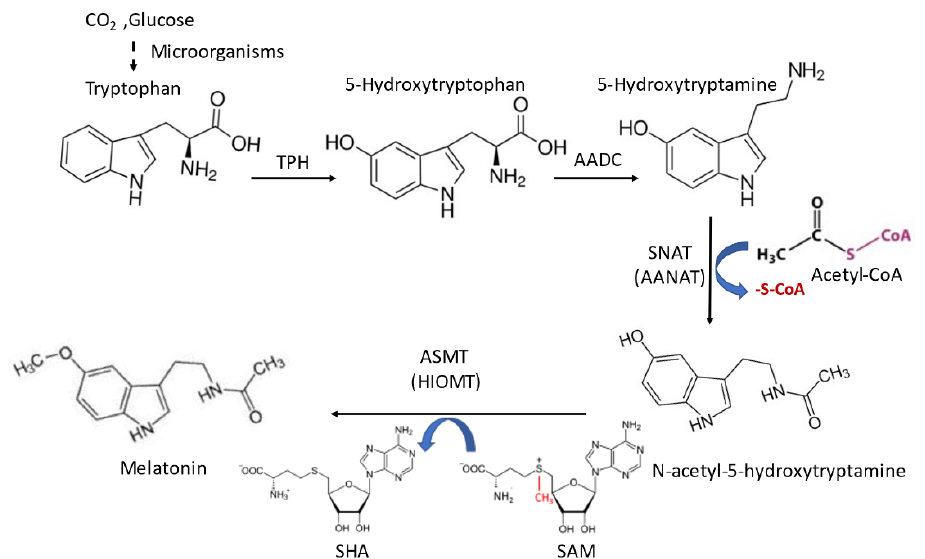
Figure 1. The classic melatonin biosynthetic pathway in microorganisms and animals. Melatonin synthesis occurs primarily in the mitochondria of the cells. TPH: tryptophan hydroxylase, AADC: aromatic amino acid decarboxylase, SNAT (AANAT): aralkylamine N-acetyltransferase, ASMT (HIOMT): N-acetylserotonin O-methyltransferase (hydroxyindole-O-methyltransferase), SAM: S-adenosyl methionine, SHA: S-adenosyl homocysteine.